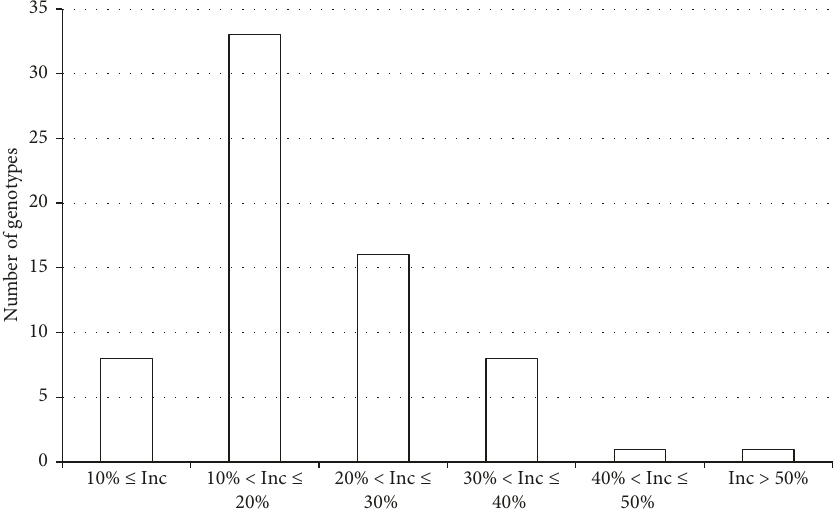
Figure 2: Number of peanut genotypes showing aflatoxin presence according to incidence